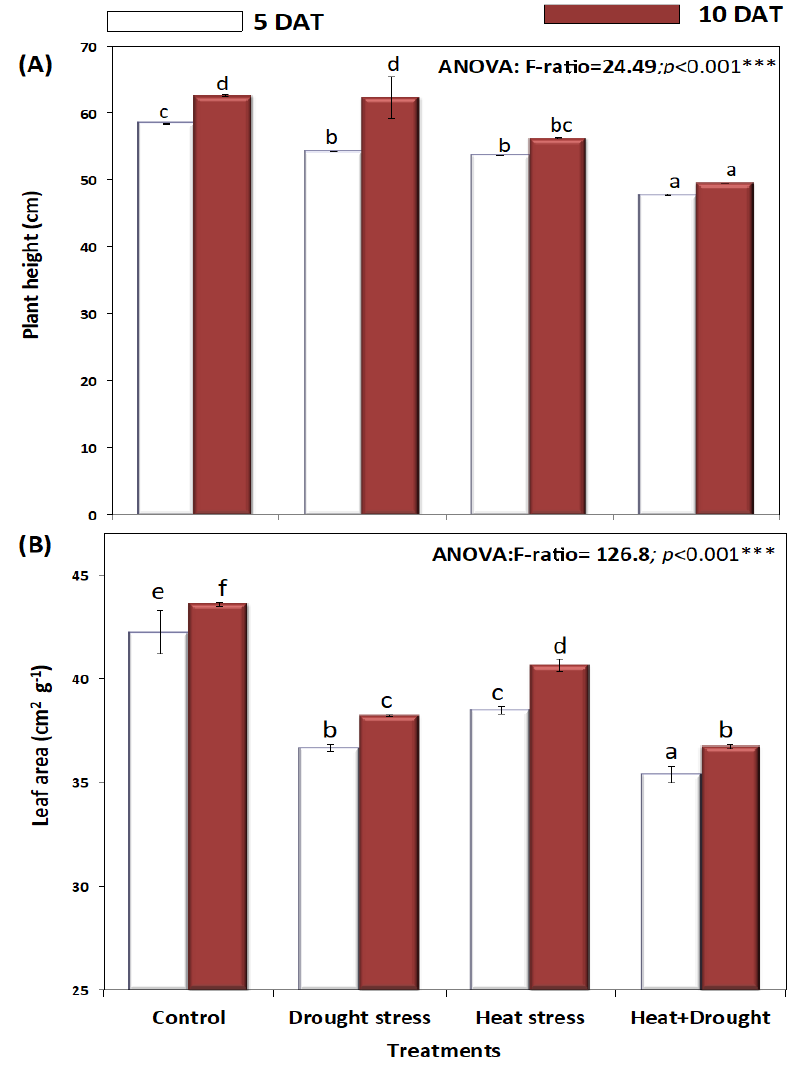
Figure 1. Effect of drought, heat, and interaction between drought and heat stress on ( A ) plant height (cm) and ( B ) leaf area (cm 2 g −1 ) of A. sieberi alba. Data expressed as mean of triplicates, error bars represent standard error for means. Means marked with different letters are significantly different according to ANOVA and Duncan’s multiple range comparisons (DMRTs) at p < 0.05.